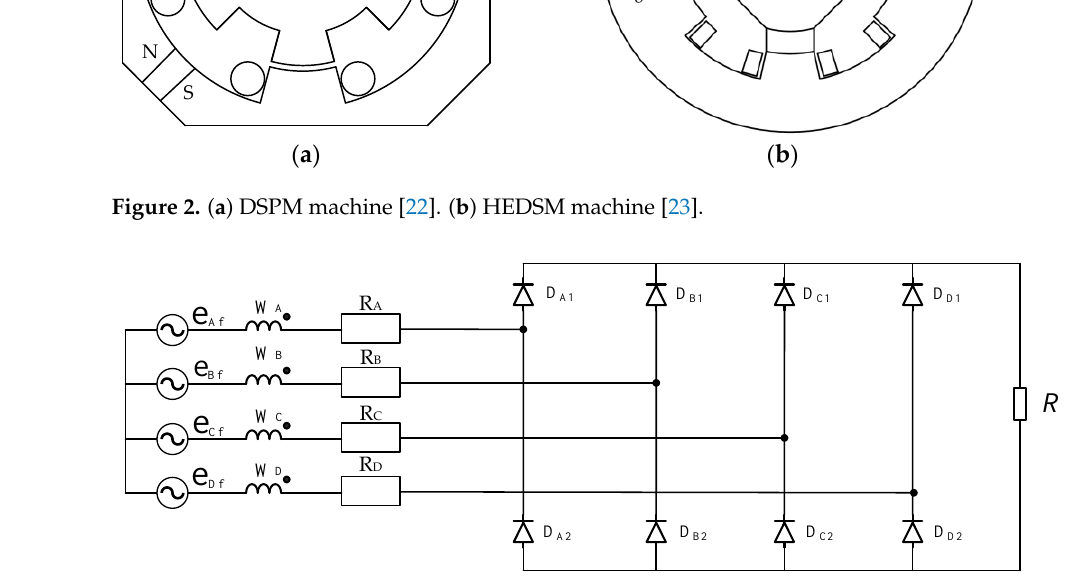
Figure 3. Full bridge rectifier circuit [25].